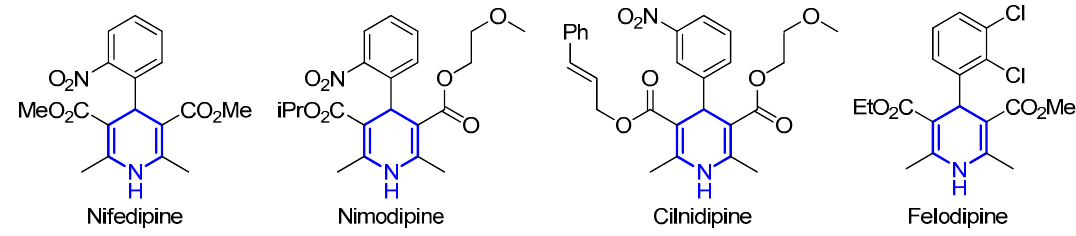
Figure 2. Biologically active 1,4-DHPs.